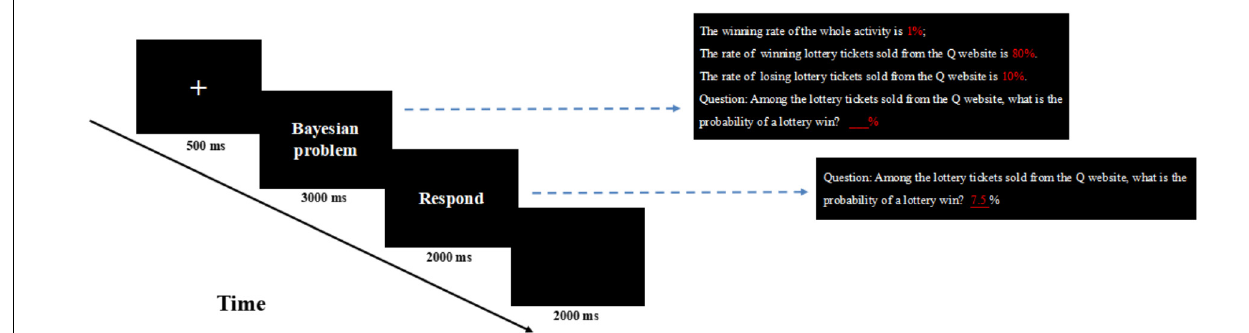
FIGURE 1 | The presentation of the Bayesian reasoning stimulates.